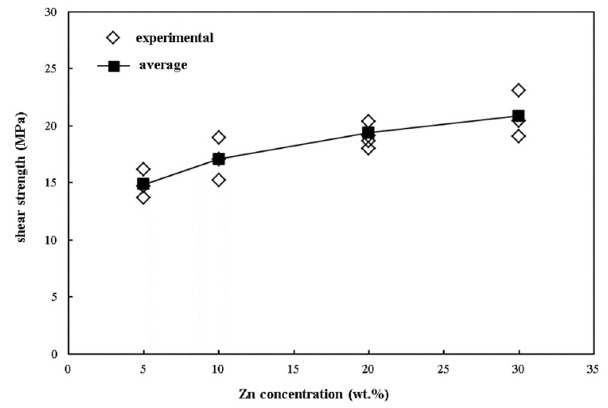
Figure 3. The shear strengths of 6061 aluminum alloy/AZ31 magnesium alloy joints bonded with Sn-xZn-0.1RE filler metals with various Zn contents.